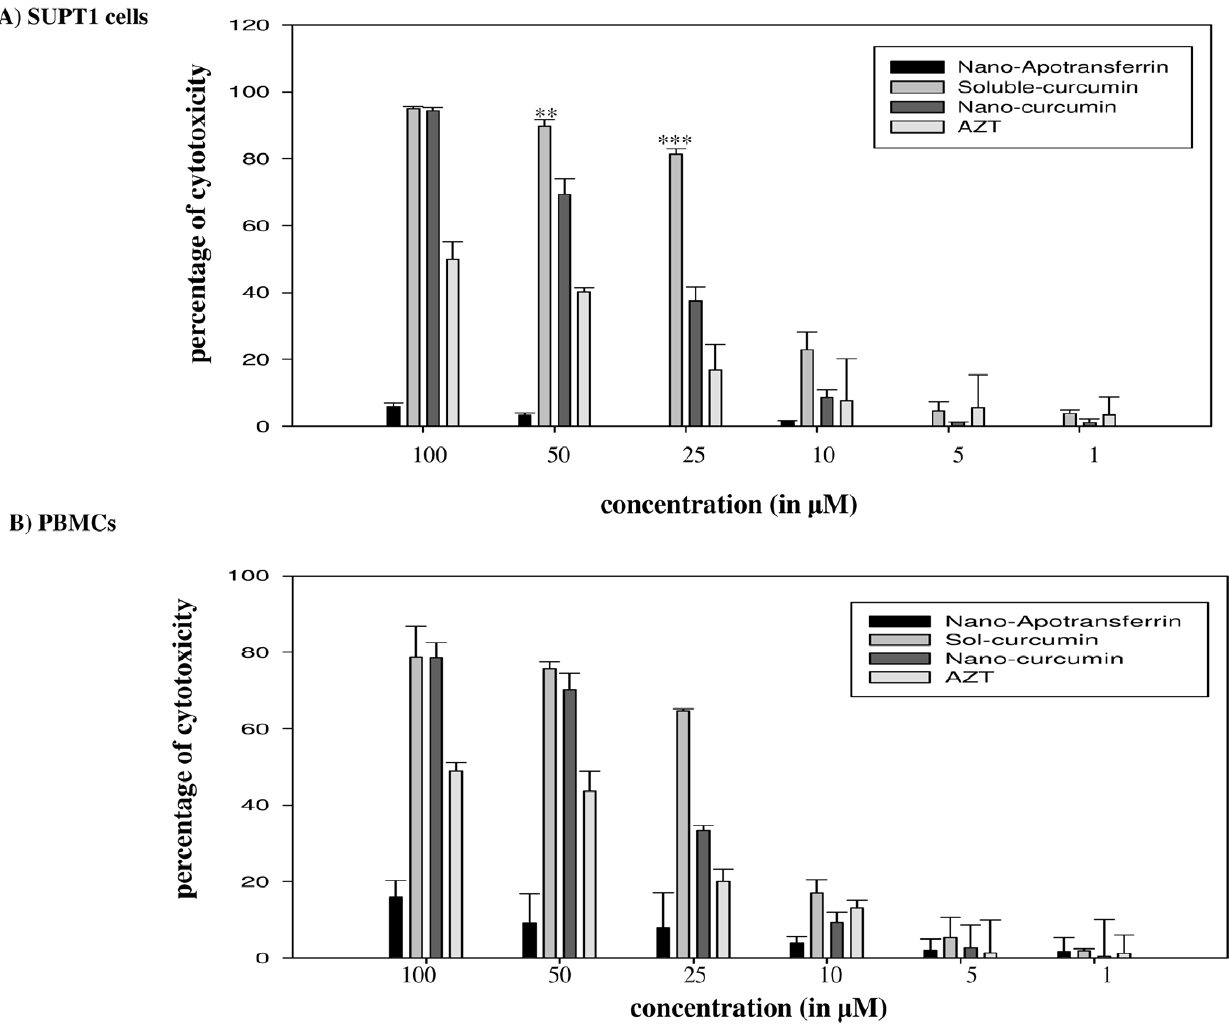
Figure 5. Nanoparticle formulation decreases curcumin cytotoxicity. SUPT1 cells (Panel A) or stimulated PBMCs (Panel B) were exposed to increasing concentrations (1, 5, 10, 25, 50 and 100 m M) of sol-curcumin, nano-curcumin, azidothymidine (AZT) or nano-apotransferrin (10, 50 and 100 m g) for 16 h, after which cell viability was determined by MTT assay. PBMCs were cultured in the presence of IL-2 (20 IU/ml). Cell viability in the absence of drug was defined as 0% cytotoxicity. Error bars indicate SD. ** P # 0.01, and ***, P # 0.001 compared to nano-curcumin. * indicates m g apotransferrin protein that carry equivalent molar concentration of the drug.